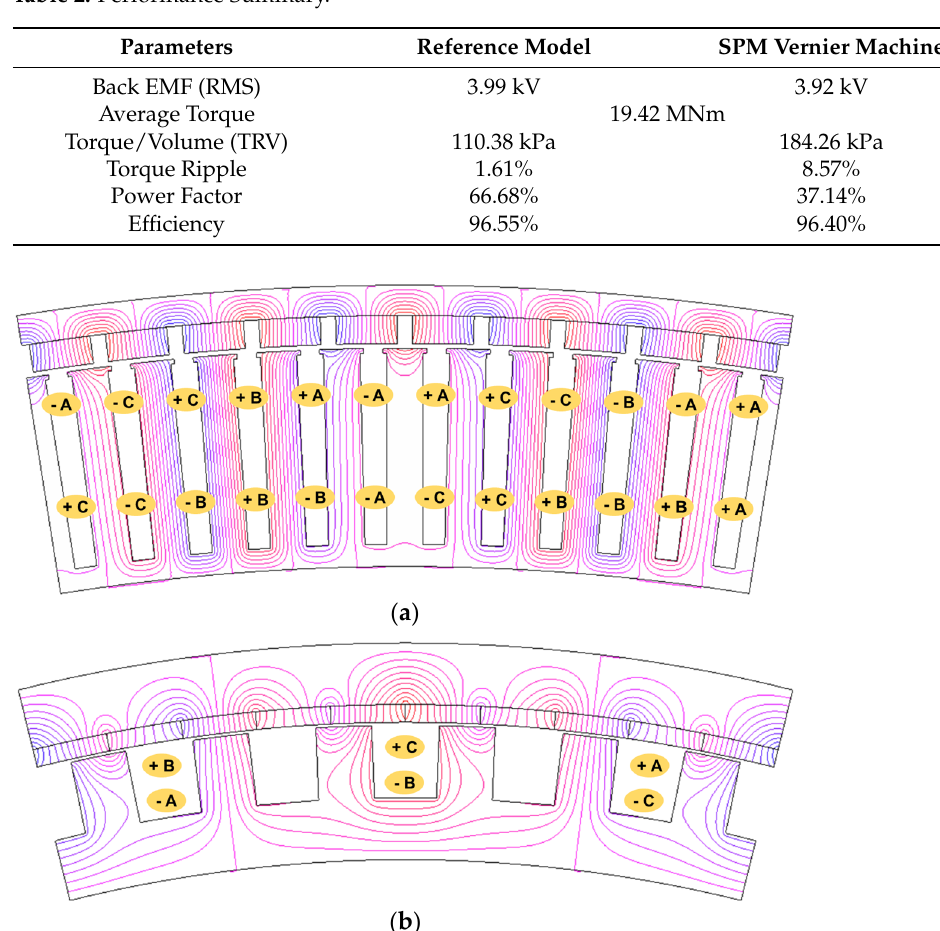
Figure 11. Comparison of back EMF waveforms (at ω rated = 7.56 rpm). Table 2. Performance Summary. Parameters Reference